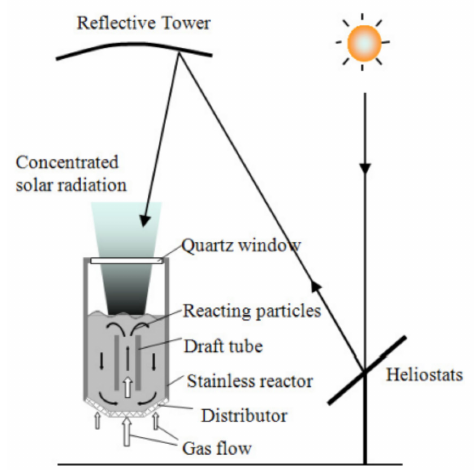
Figure 6. Fluidized-bed solar reactor for two-step thermochemical water splitting. The reduction reaction takes place in a nitrogen atmosphere at 1400 ◦ C and steam is supplied for the oxidation reaction, which is conducted at 1000 ◦ C. Reprinted from